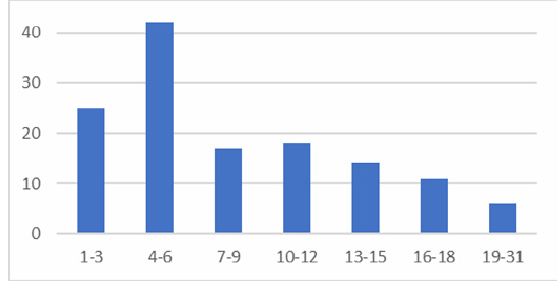
Figure 1. Number of apps known by participant Those who use and trust represent 28,8% of those who know an app and 70.2% of those who use ((b)/(a) in table